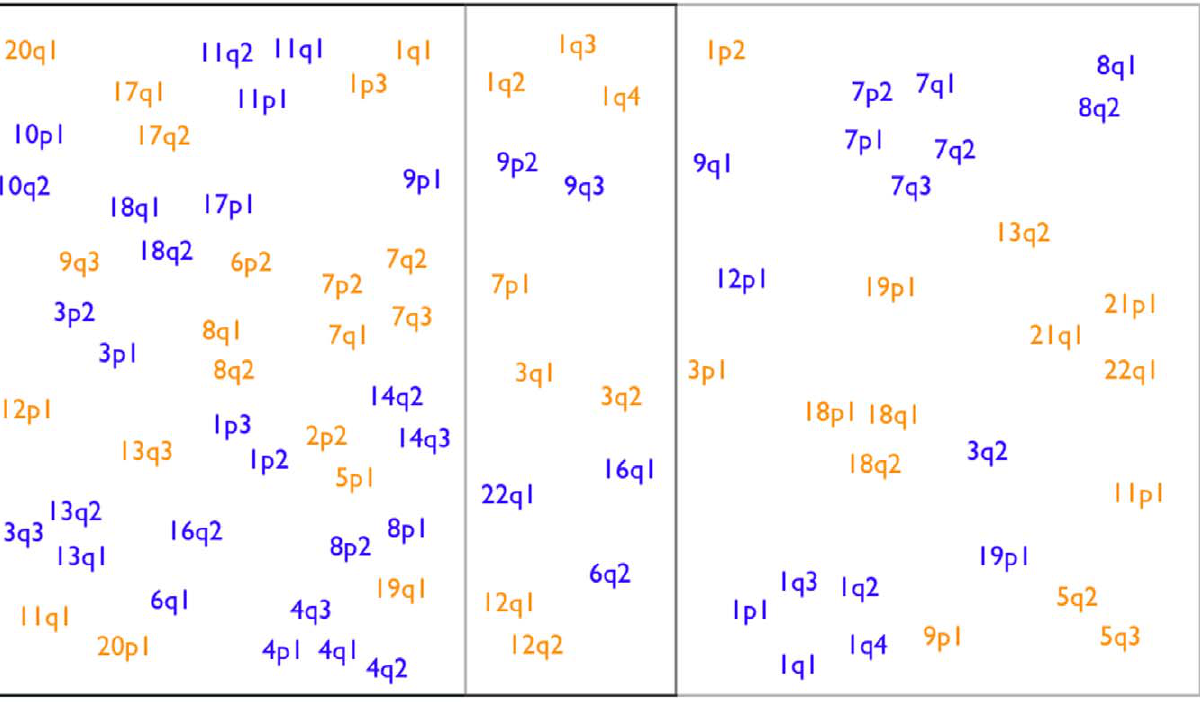
Figure 5. Comparison of non-neutral vs. hot-spot CNA. Genomic regions affected by CNAs, either more frequently than average (black rectangle), or non-neutrally with respect to cancer-type classifications (grey rectangle). The intersection defines regions that are affected both frequently and non-neutrally. Changes are color-coded (gains in orange and losses in blue).